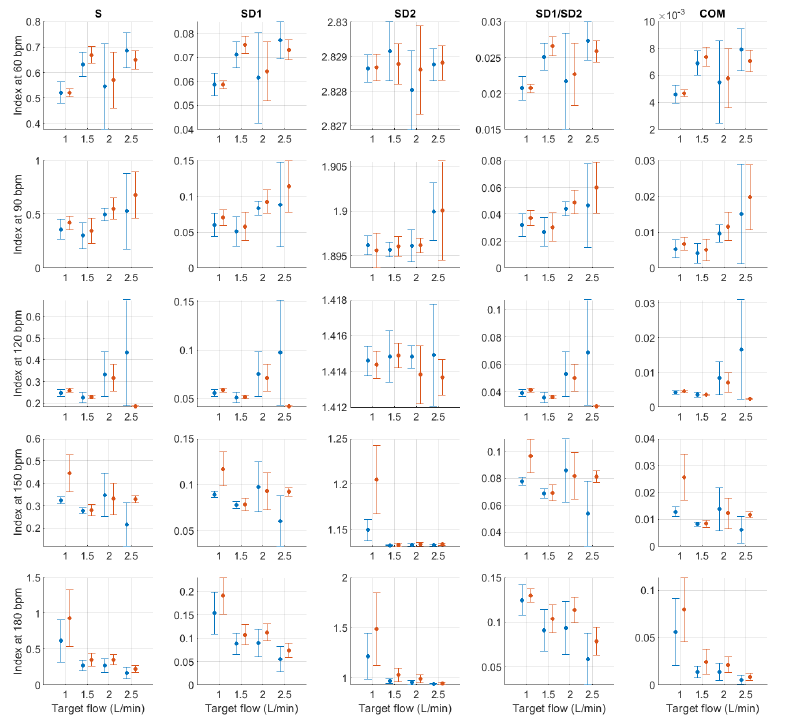
Figure A14. Mean and standard deviation of Poincaré plot indices extracted from pulse rate variability under different stroke rates (SR) and target flows (TF, TF below 2.5 L/min) conditions, and measured from the radial (blue) and deep palmar arch (orange)